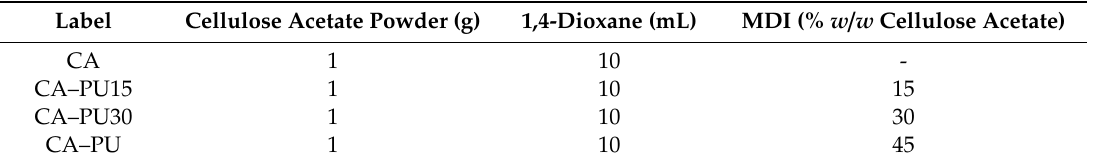
Table 1. Composition of neat cellulose acetate (CA) and cellulose acetate–polyurethane (CA–PU) film